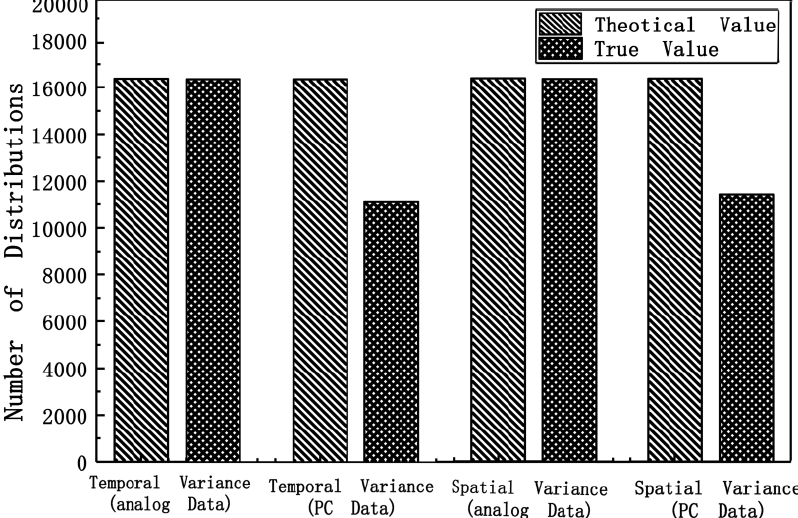
Figure 5. Statistics of the number of non-zero distributions from the scatter plots of spatial variance and temporal variance shown in Figures 3 and 4.